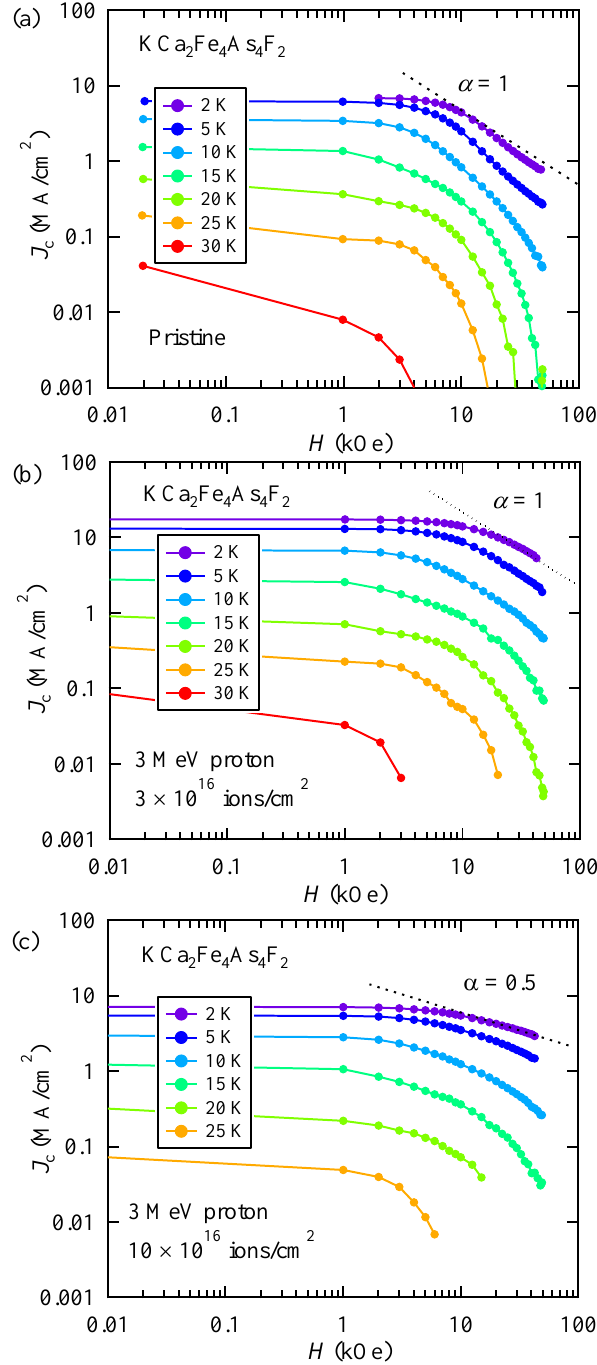
Figure 4. Magnetic field dependence of critical current densities for H // c at various temperatures in ( a ) the pristine and 3 MeV proton irradiated KCa 2 Fe 4 As 4 F 2 with dose of ( b ) 3 × 10 16 or ( c ) 10 × 10 16 ions/cm 2 .